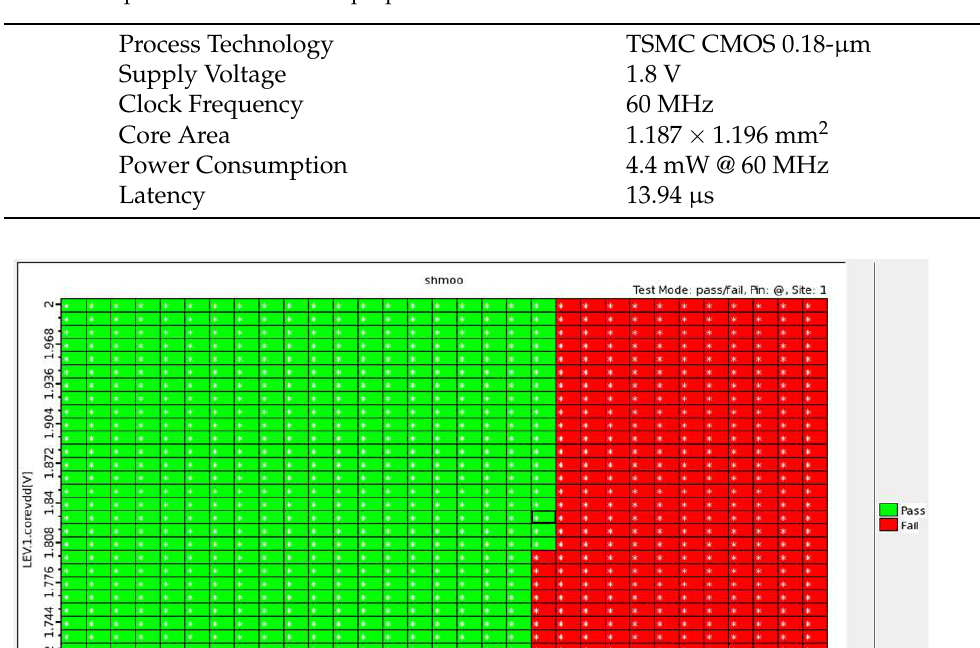
Figure 9. The layout ( left ) and photomicrograph ( right ) of the proposed CNN accelerator. Table 4. Chip characteristics of the proposed CNN accelerator.